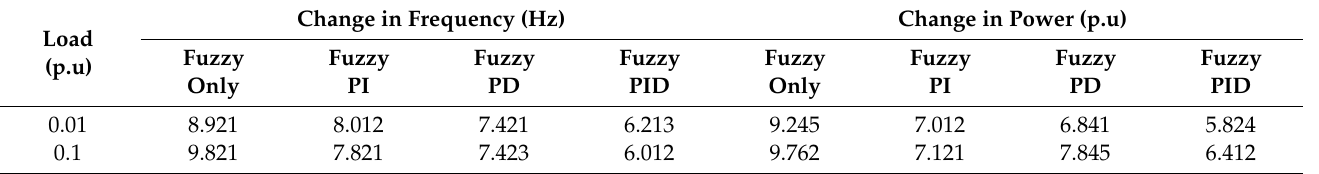
Table 3. Amplitude of oscillations for frequency and power of the hybrid system for Fuzzy, Fuzzy-‘PI’, Fuzzy-‘PD’ and Fuzzy-‘PID’ against different Figure 12. Dynamic response comparison of different control configurations of IHPS power change with step input of 1% increase in load.